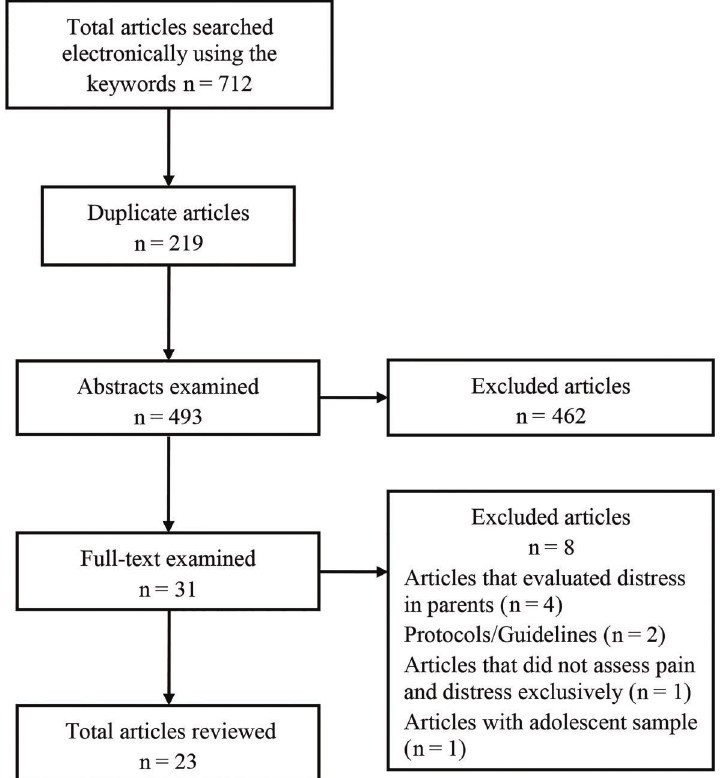
Figure 1. Flowchart of the search strategy used in the